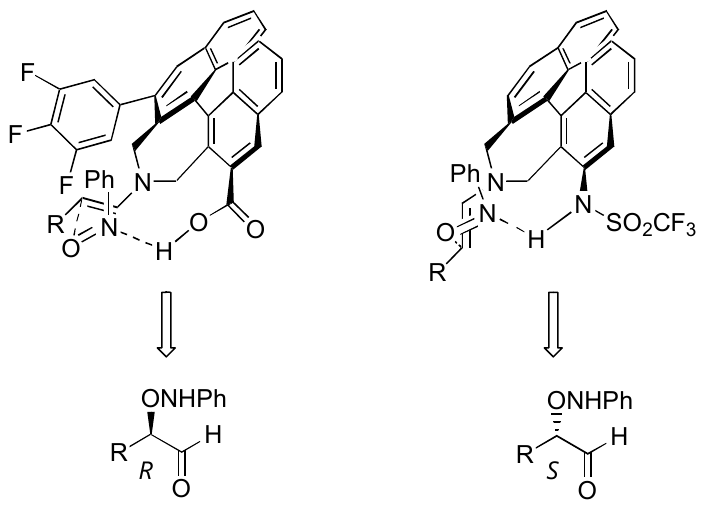
Figure 21. Transition state models to explain the opposite enantioselectivities observed with the catalysts 31 (left) and 32 (right)